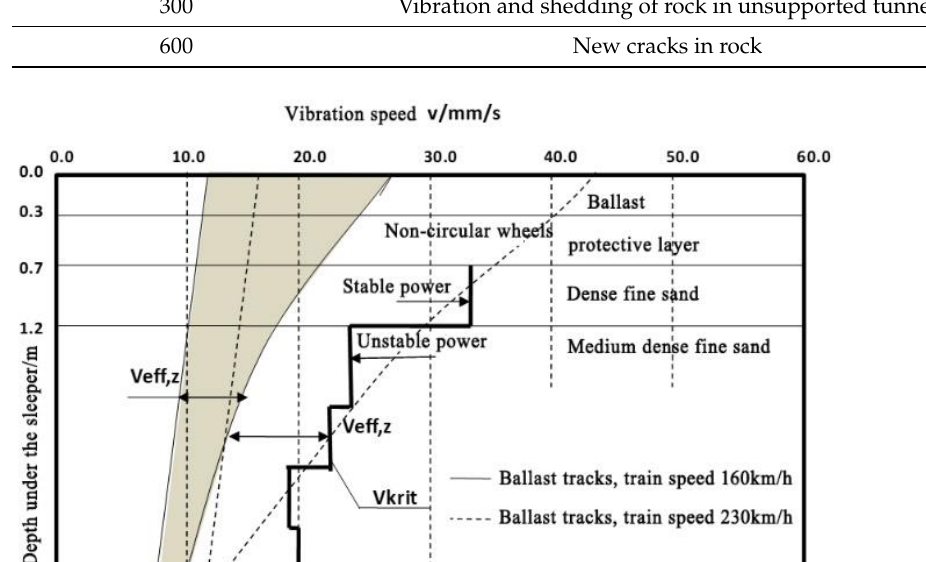
Figure 12. The dynamic stability and vibration velocity at different depths.